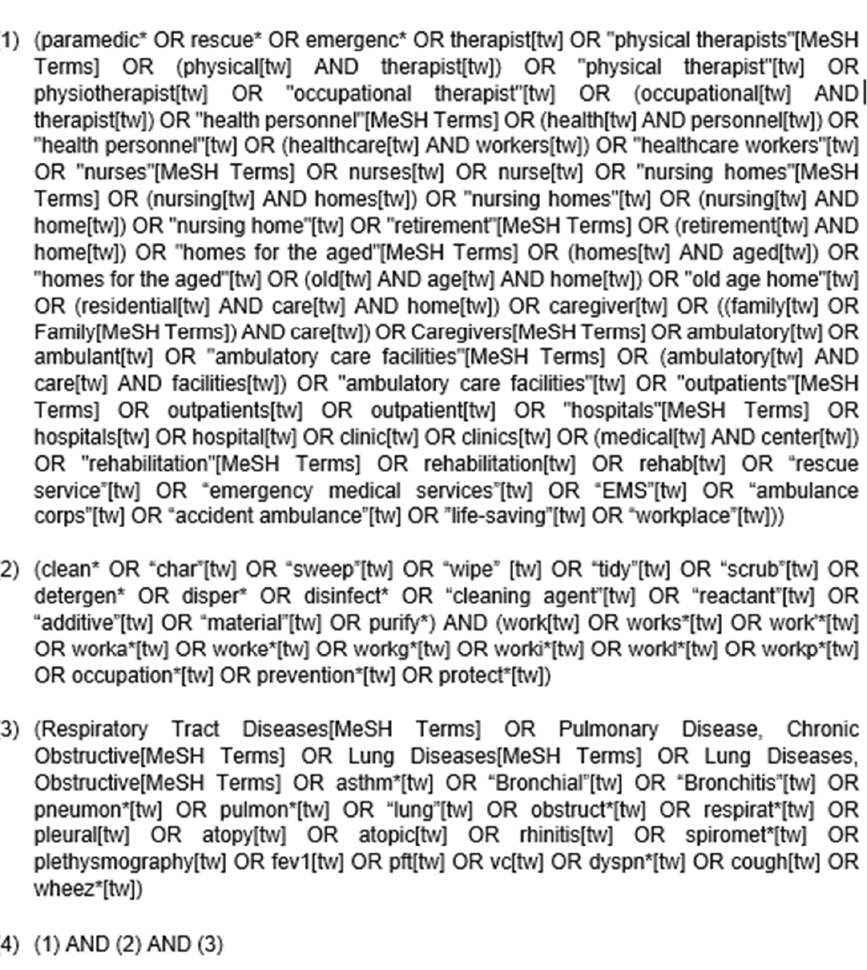
Figure 1. The MEDLINE (PubMed) search strategy.